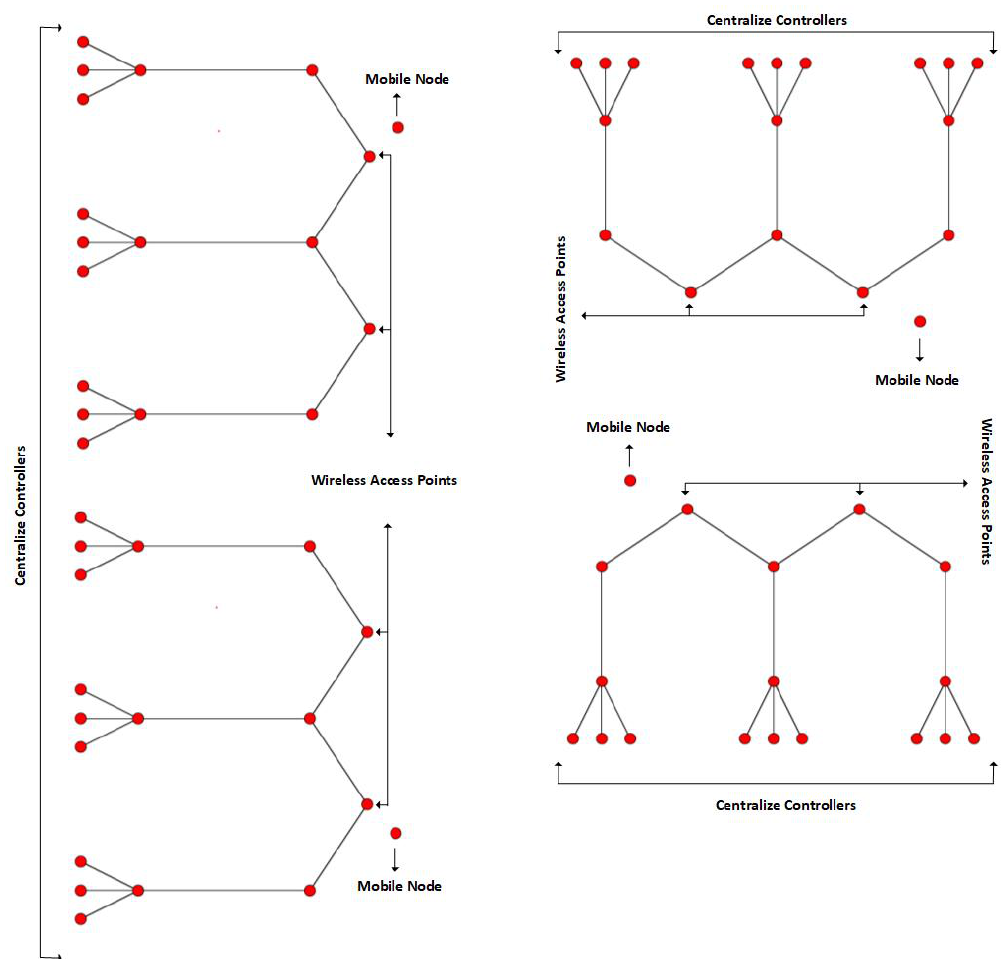
Figure 9. Simulation